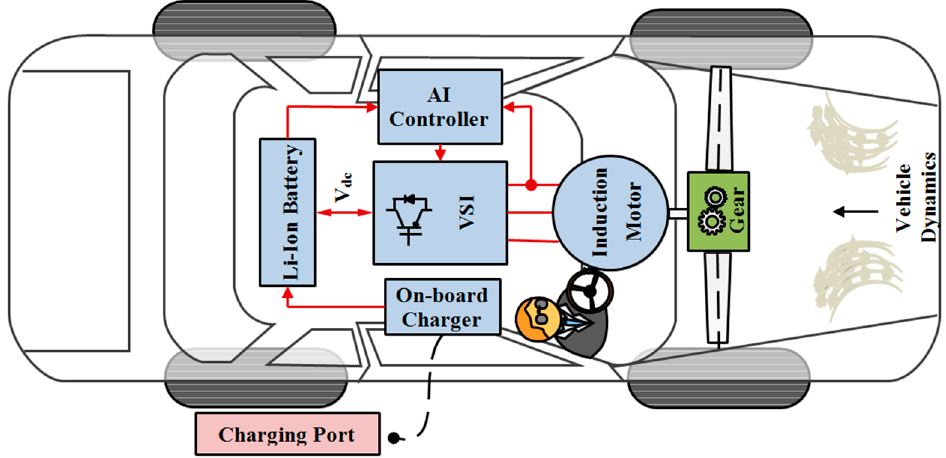
Figure 1. The architecture of a front wheel drive (FWD) electric car (eCAR).